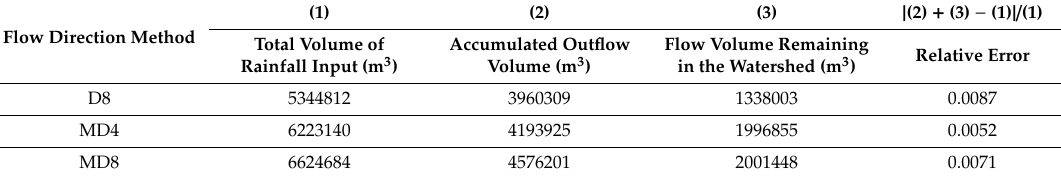
Table 2. Mass conservation test based on different flow-direction methods.